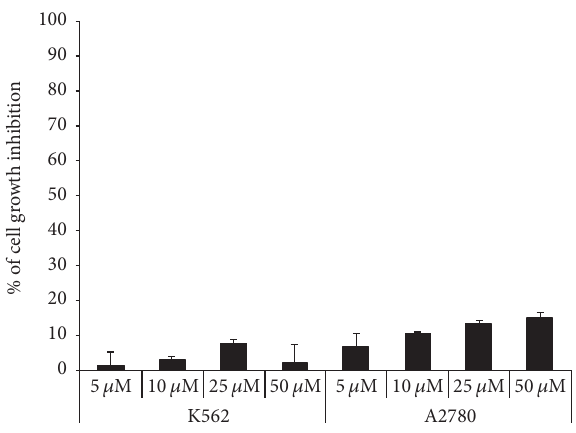
Figure 3: In vitro antiproliferative effect of NAF on K562 cells and A2780 cells. Data represent the percentages of cell growth inhibition compared to untreated control cells. Data are the mean of three independent experiments ± s.d. conducted in triplicate. 𝑃 values are always <